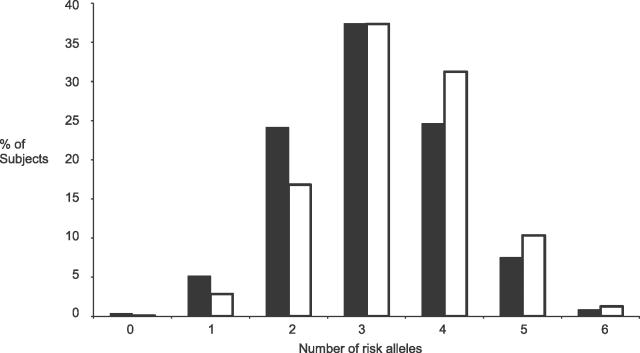
The Distribution of Risk Alleles in the Controls and CasesControls are indicated by black bars, cases by white bars.